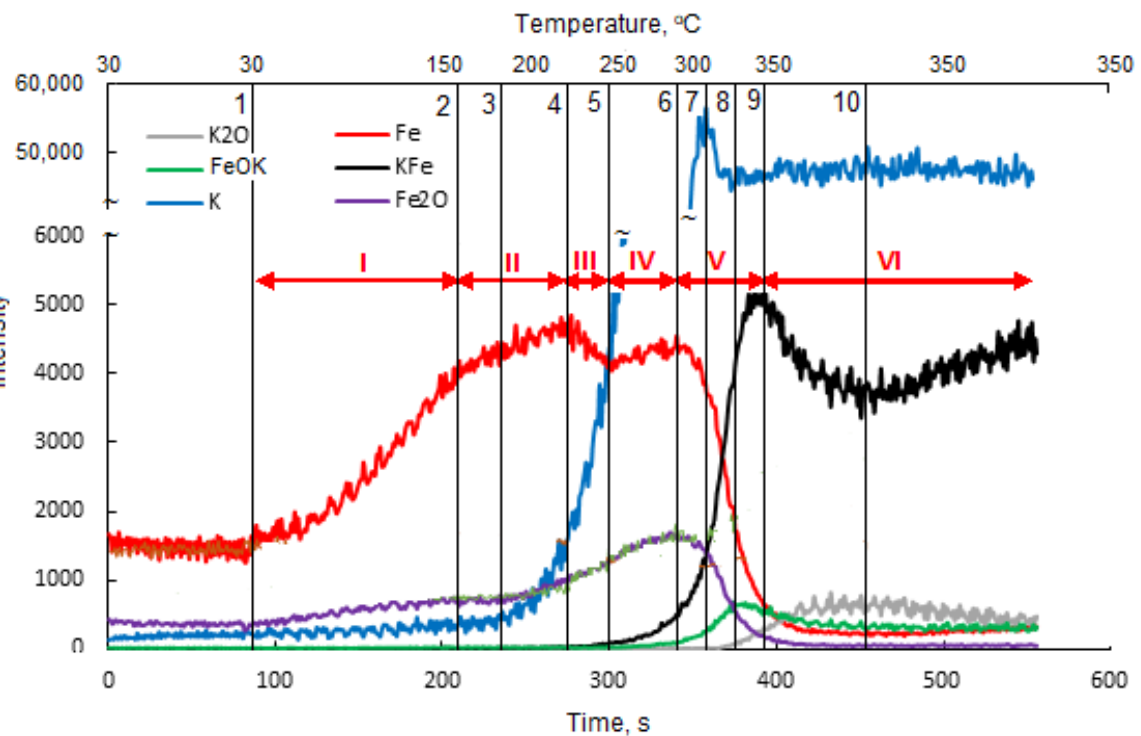
Figure 2. Temperature-programmed TOF-SIMS profile of the Fe-K sample.